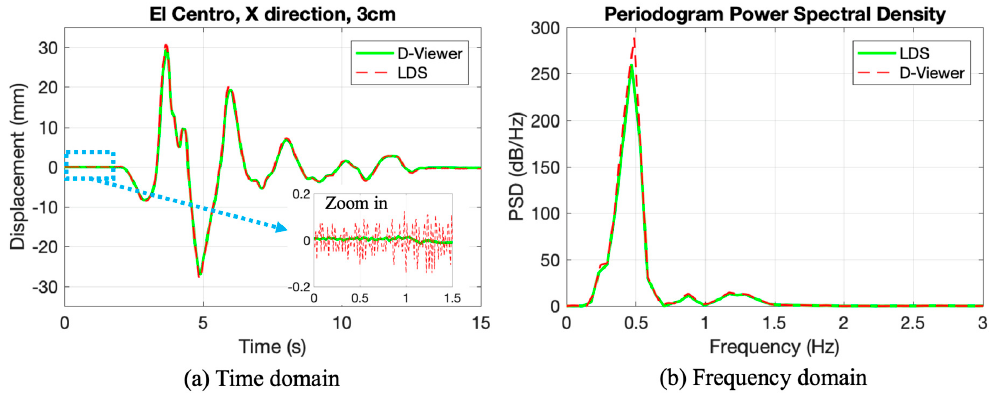
Figure 7. The results of experiments #12: ( a ) Time domain; ( b ) Frequency domain.